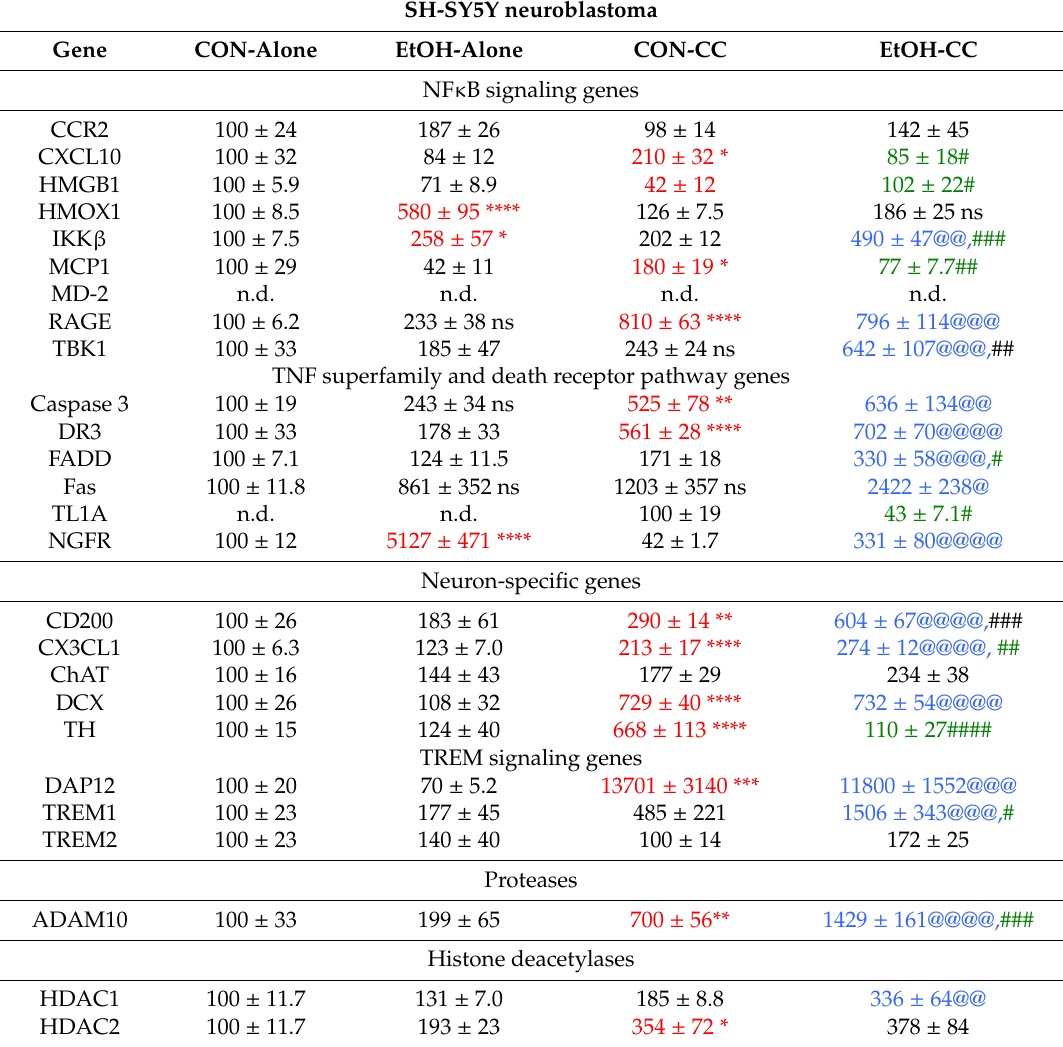
Table 3. Summary of e ff ects of ethanol and co-culture on gene expression in SH-SY5Y. SH-SY5Y